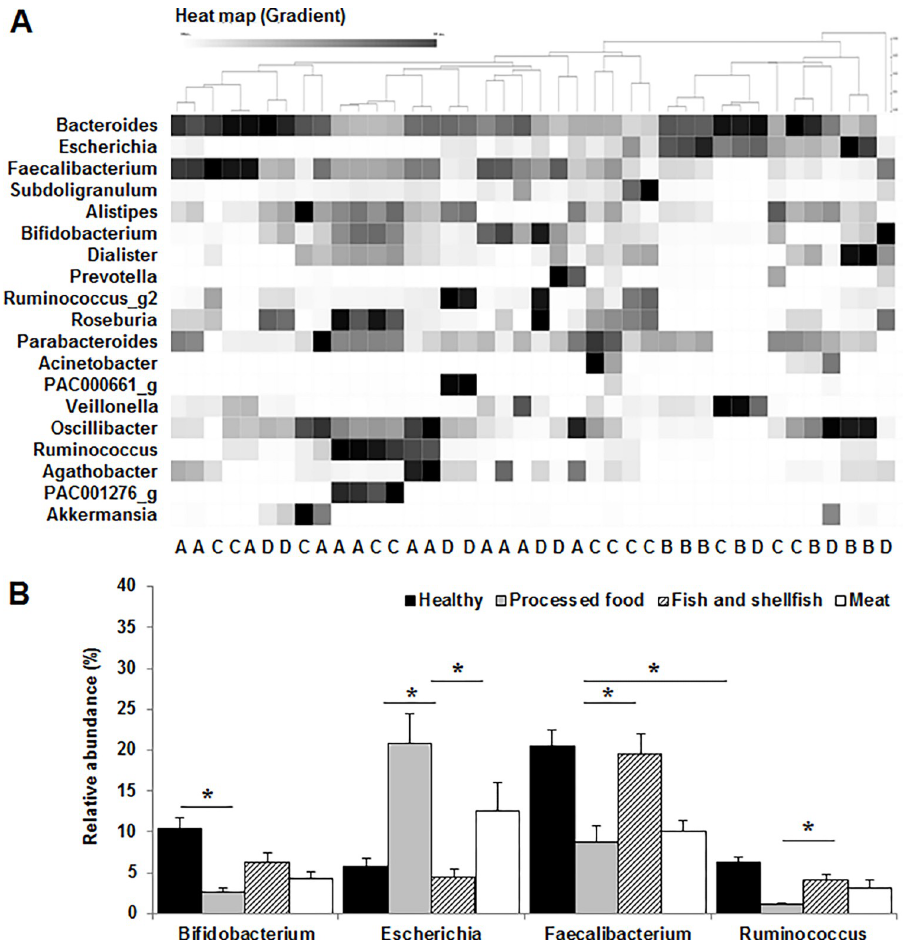
Fig 1. Comparison of the gut microbiota at the genus level according to the dietary patterns. ( A ) Heat map of different genera in the gut microbiota. A, healthy; B, processed food; C, fish and shellfish; D, meat. ( B ) Relative abundance of the gut microbiota. Values are expressed as the mean ± standard error of the mean (SEM). Statistical significance was determined by one-way analysis of variance (ANOVA) with Duncan’s multiple range test ( � p < 0.05).